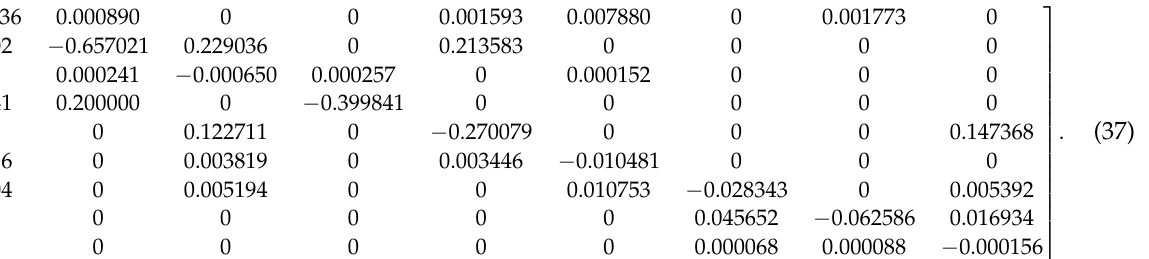
Figure 8. Readiness indicators values obtained in sensitivity analysis of SMM.